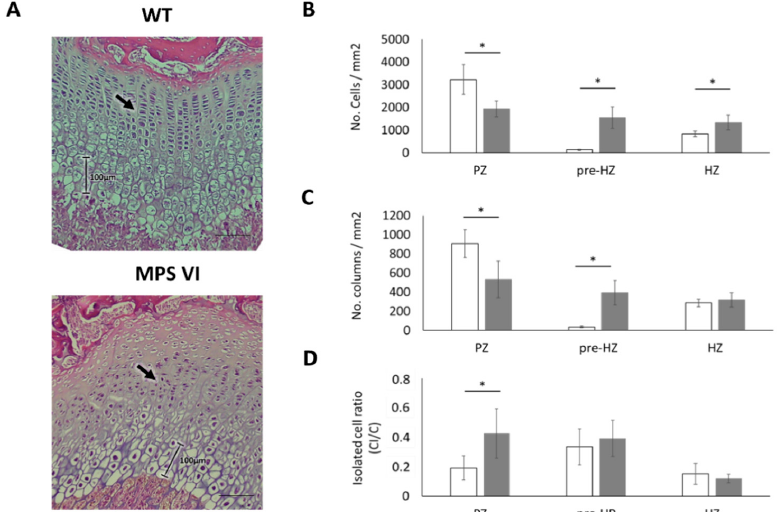
Figure 4. Histological characteristics of growth plates from 1-month-old WT and MPS VI rats. ( A ) Histological sections stained with hematoxylin and eosin. In the images, a severe loss of columnar arrangement is observed (arrow head). In addition, a change in the size of hypertrophic chondrocytes is observed. Images are at 20× magnification. Scale bars correspond to 100 µm; ( B ) Cell density results per zone; ( C ) Column density (CD) results per zone; ( D ) Results for isolated cells ratio (CI/C) per zone. Open and black bars correspond to wild type (WT) and MPS VI rats, respectively. Result are reported per growth plate zone as follows: proliferative (PZ), pre-hypertrophic (pre-HZ), and hypertrophic (HZ) zones ( n = 3 per group). The symbol (*) indicates a statistically significant difference ( p < 0.05).